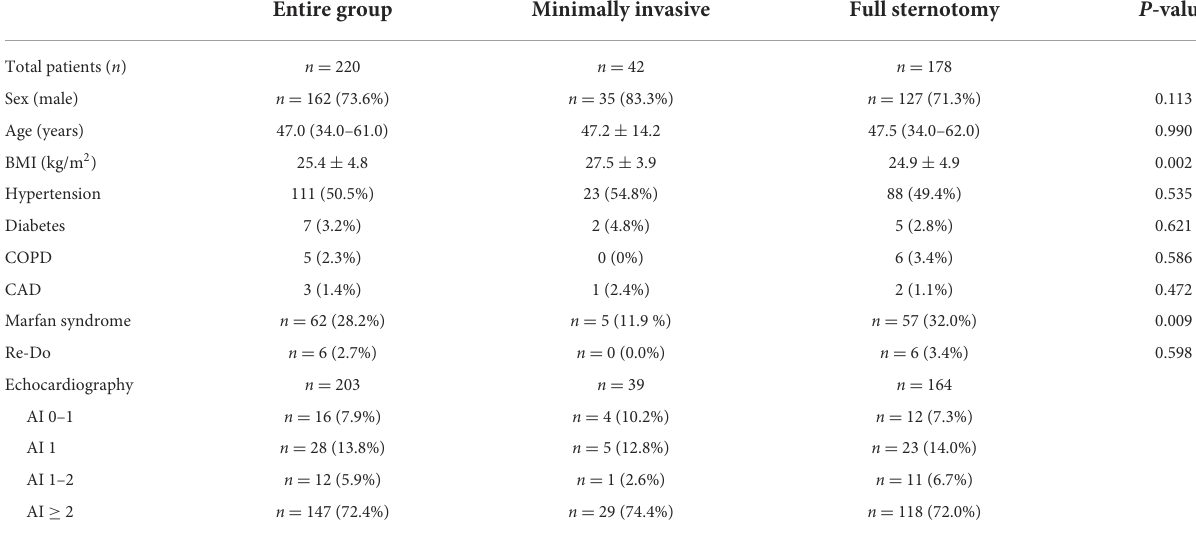
TABLE 1 Patient